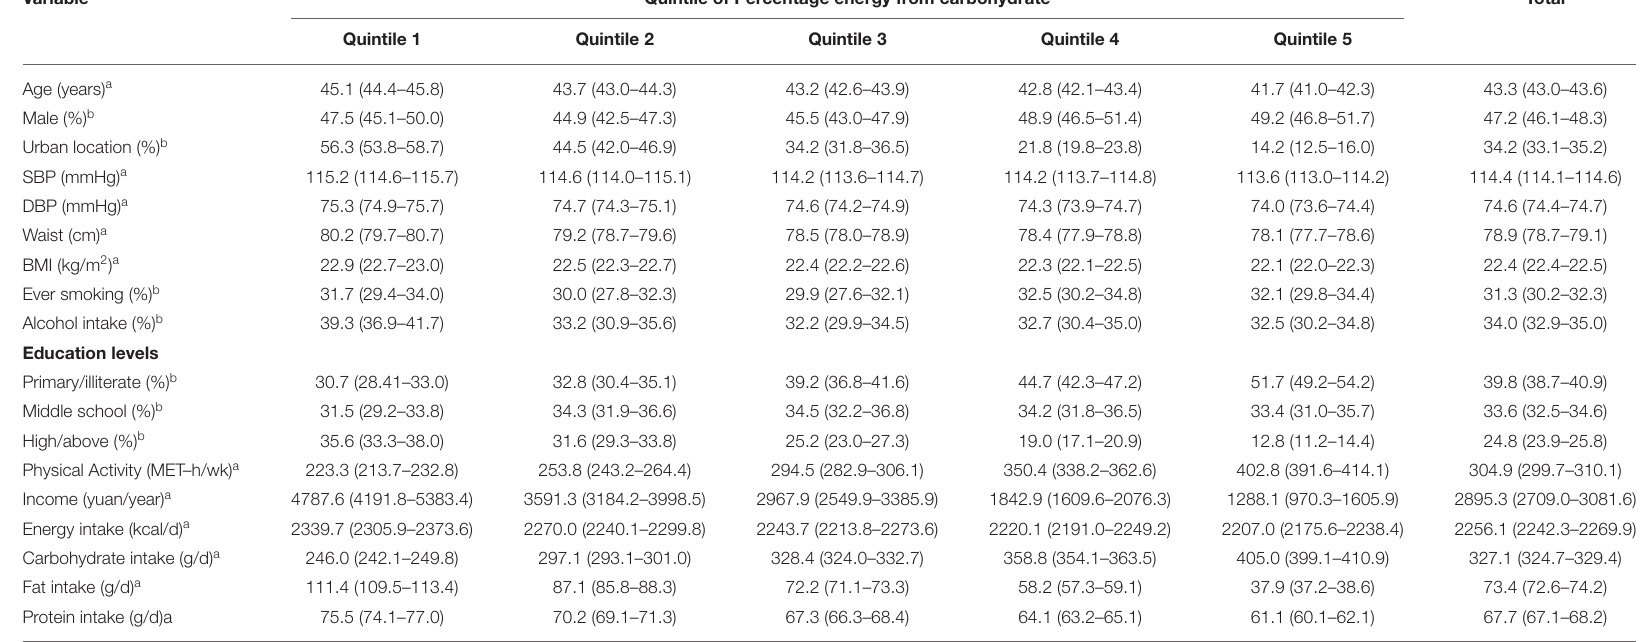
TABLE 1 | Characteristics of the study participants at the baseline ( n =